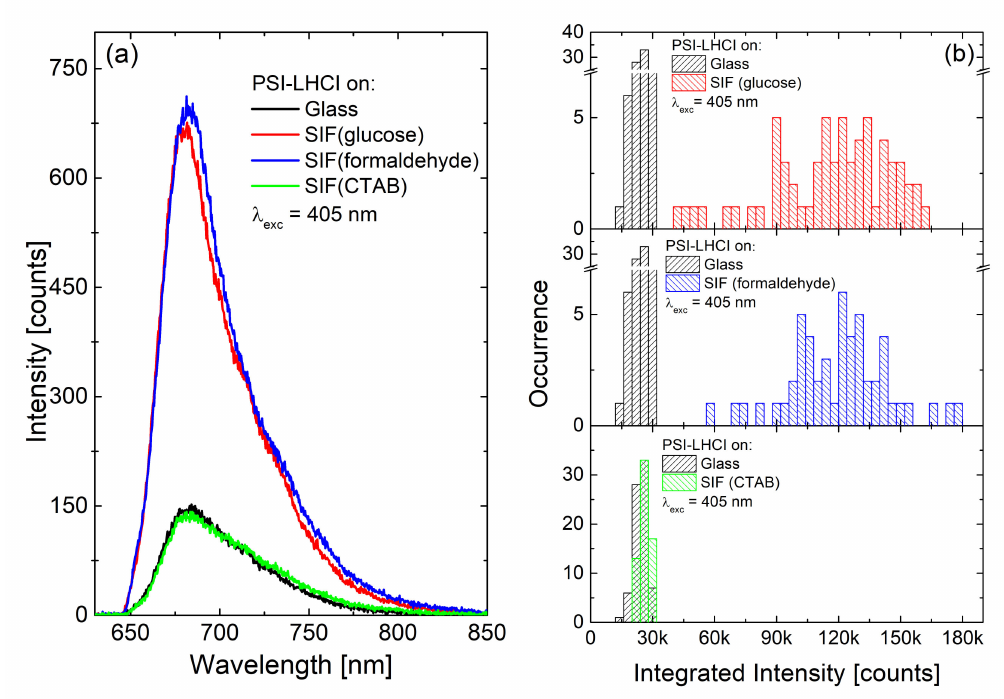
Figure 9. Emission spectra ( a ) and histograms of emission intensities ( b ) of Cyanidioschyzon merolae PSI-LHCI supercomplex: on glass (black), SIF (glucose) (red), SIF (formaldehyde) (blue), and SIF (CTAB) (green), the excitation wavelength is 405